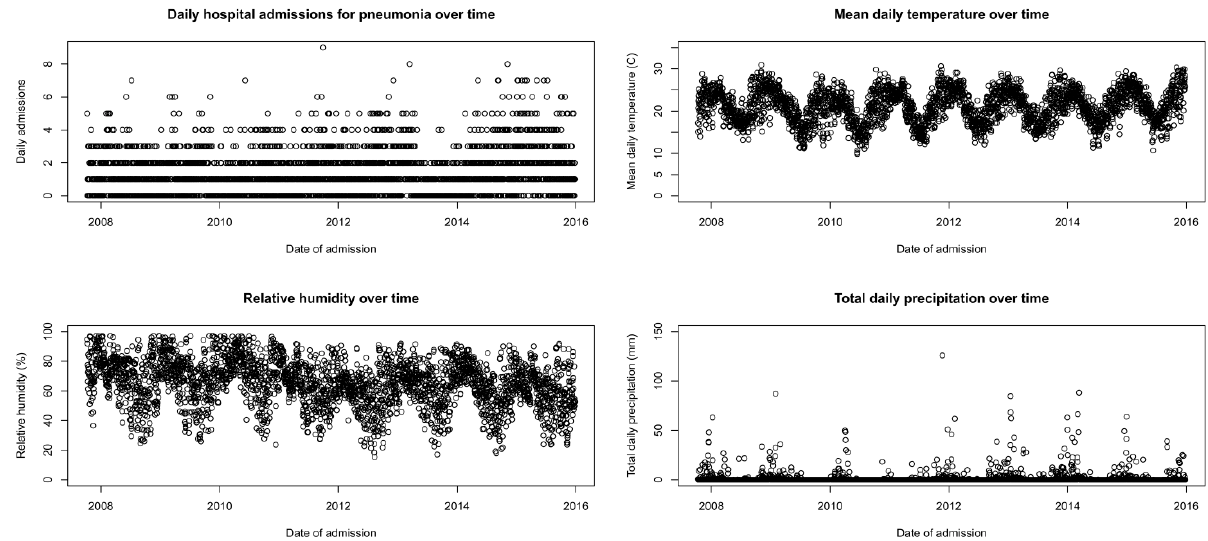
Figure 2. Daily pneumonia hospital admissions and meteorological variables by date.